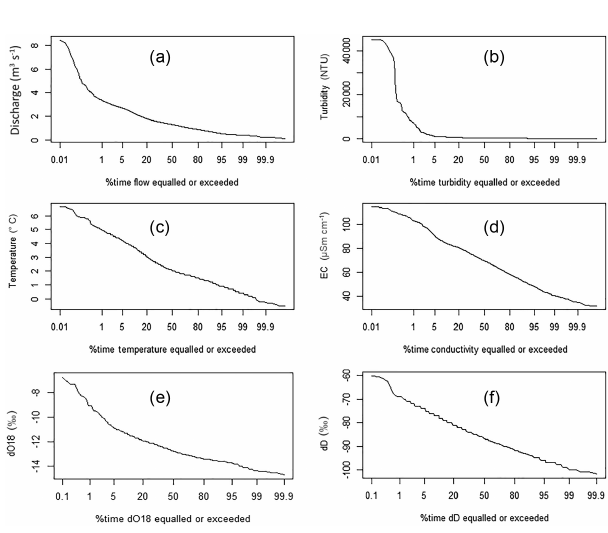
Figure 4. Duration curves of the parameters measured during 2007–2017 at the Djankuat gauging station: (a) water discharge, (b) optical turbidity, (c) water temperature, (d) water electrical con- ductivity, (e) δ 18 O, (f) δ D.